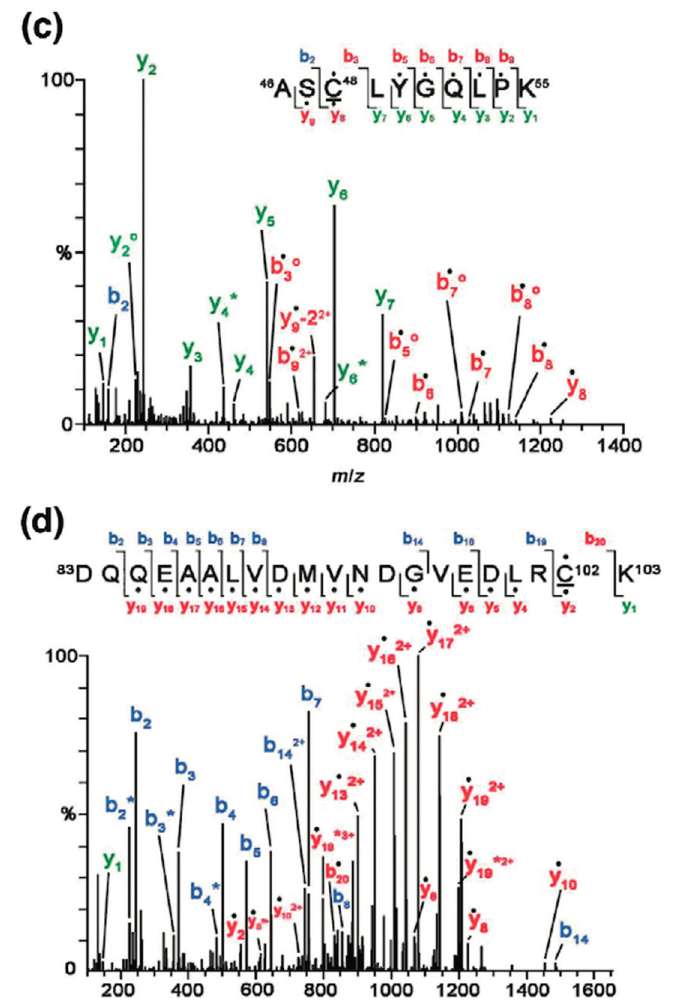
Figure 6. GspS as a tool for probing protein S -glutathionylation [56]. ( a ) the structure of biotinylated glutathionylspermine, Gsp-biotin. This substrate is readily accepted by Gsp amidase and can be hydrolyzed to GSH and spm-biotin enzymatically; ( b ) Workflow for site-specific identification of protein glutathionylation in gsps -transfected 293T cells. Cells are lysed and treated with iodoacetamide (IAM) to block free thiols. After tryptic digestion, Gsp-biotin S -thiolated peptides are enriched by streptavidin resin, followed by GspA hydrolysis to remove biotin-spm, leaving intact GSH on labeled peptides; ( c , d ) are MS/MS spectra derived from two glutathionylated tryptic peptides of glutathione S -transferase pi (GST π ), which afford the [M+2H] 2+ precursor ion at m/z 692.82 for the Cys48-containing peptide (c) and the [M+3H] 3+ precursor ion at m/z 885.05 for the Cys102-carrying peptide (d). The amino acid sequences and respective b- and y- ions are shown in each spectrum, with the glutathionylated cysteine residues underlined. Filled circles (dots) above the labeled ions indicate product ions carrying a GSH moiety, which contributes to a mass increment of 305 Da relative to those ions without modification. Open circles (O) and asterisks ( * ) indicate product ions containing a neutral loss of H 2 O and NH 3 , respectively. “ ‒ 2” on y-ions indicates the presence of cysteine thioaldehyde residues, which are 2 Da lower than cysteine in the molecular weight [56] © Wiley-VCH, reproduced with modifications in colors and